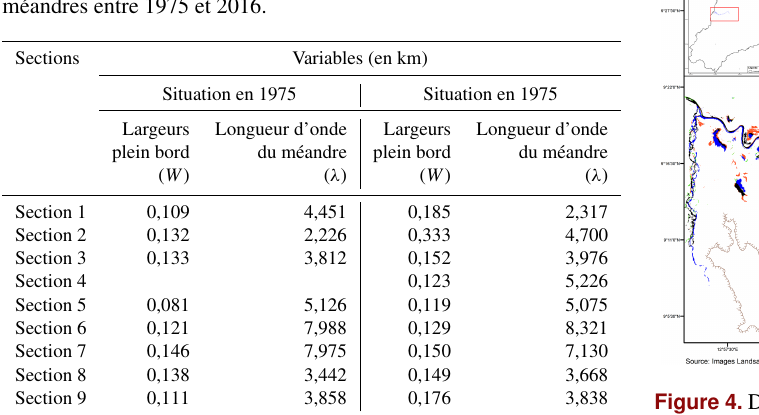
Tableau 3. Analyse comparée des largeurs et longueurs d’onde des méandres entre 1975 et 2016.